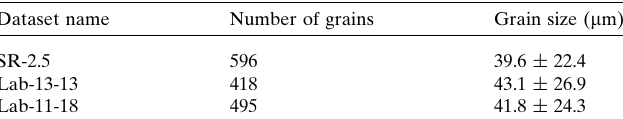
Table 1 Grain parameters obtained by the three methods. The grain size reported is expressed by the mean value and standard